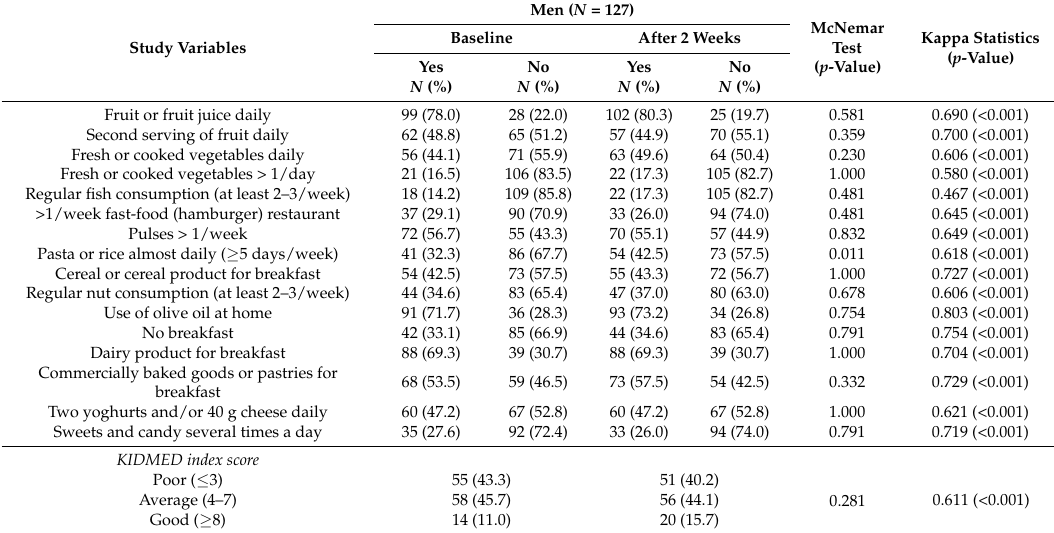
Table 3. Mediterranean Diet Quality Index statistics for men ( N = 127).